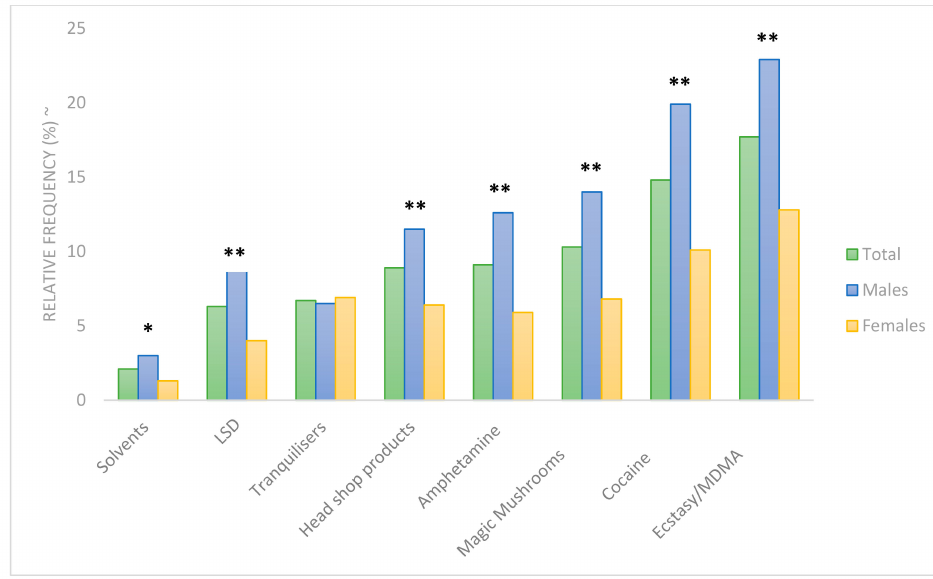
Figure 3. Lifetime use of illicit substances by sex. *significant between sexes p < 0.05 **significant between sexes p < 0.0005, ~Item valid responses: Solvents n = 1597, LSD n = 1595, Tranquilisers n = 1602, Head Shop Products n = 1598, Amphetamine n = 1599, Magic Mushrooms n = 1598, Cocaine n = 1600,